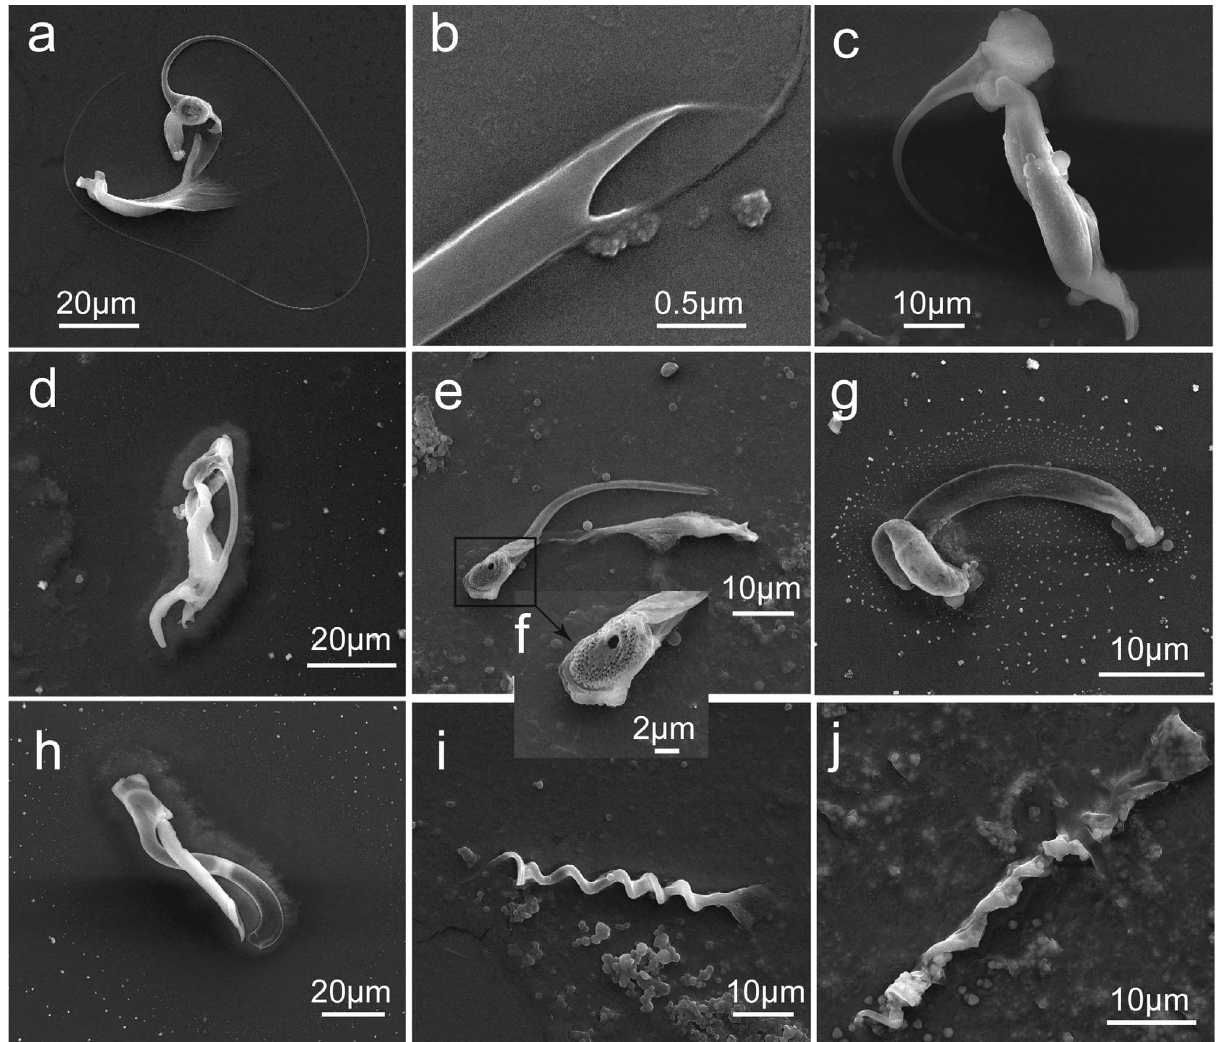
Figure 9. Scanning electron micrographs of genital sclerotized parts of species of Cichlidogyrus , Scutogyrus and Enterogyrus . (a) Male copulatory complex of C. cirratus ; (b) penis end of male copulatory complex of C. cirratus ; (c) male copulatory complex of C. sclerosus ; (d) male copulatory complex of C. thurstonae ; (e) male copulatory complex of S. longicornis ; (f) penis basement of S. longicornis ; (g) vagina of S. longicornis ; (h) male copulatory complex of C. halli ; (i) penis of E. malmbergi ; (j) penis of E. coronatus